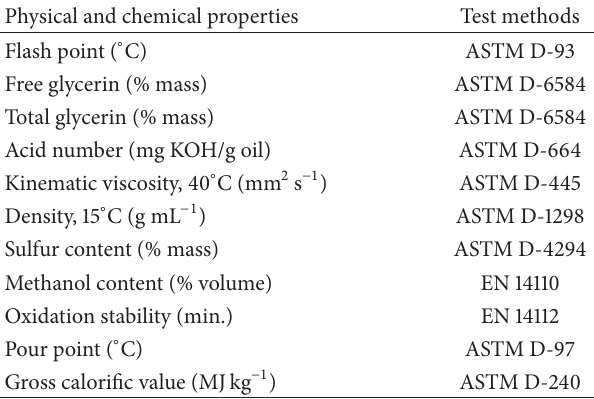
Table 1: Summary of test methods used for quality determination of cha˜nar